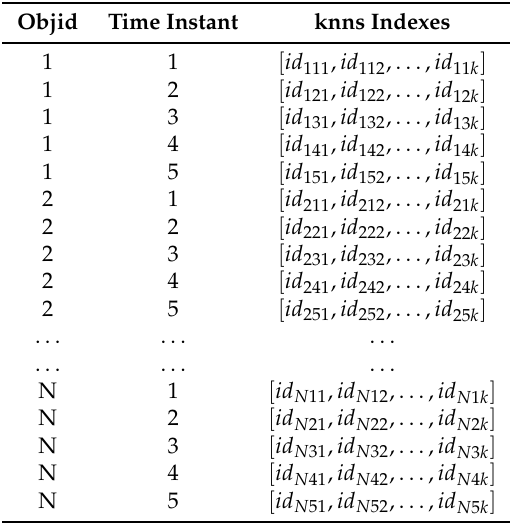
Table 2. k -anonymity sets for N mobile users in L = 5 time-stamps.